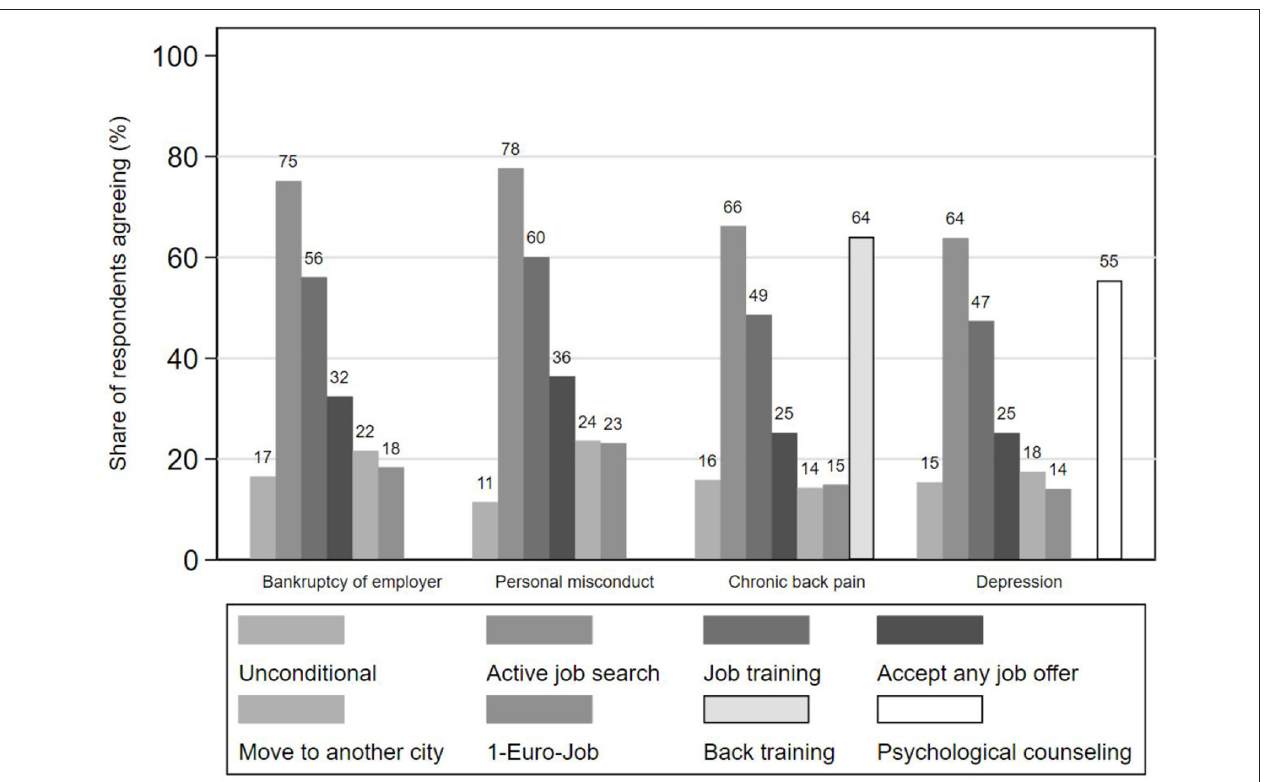
FIGURE 2 | Expected behavior for receiving the full amount of minimum income benefits for different reasons of unemployment. Vignette study ( N = 2,621), own weighted sample